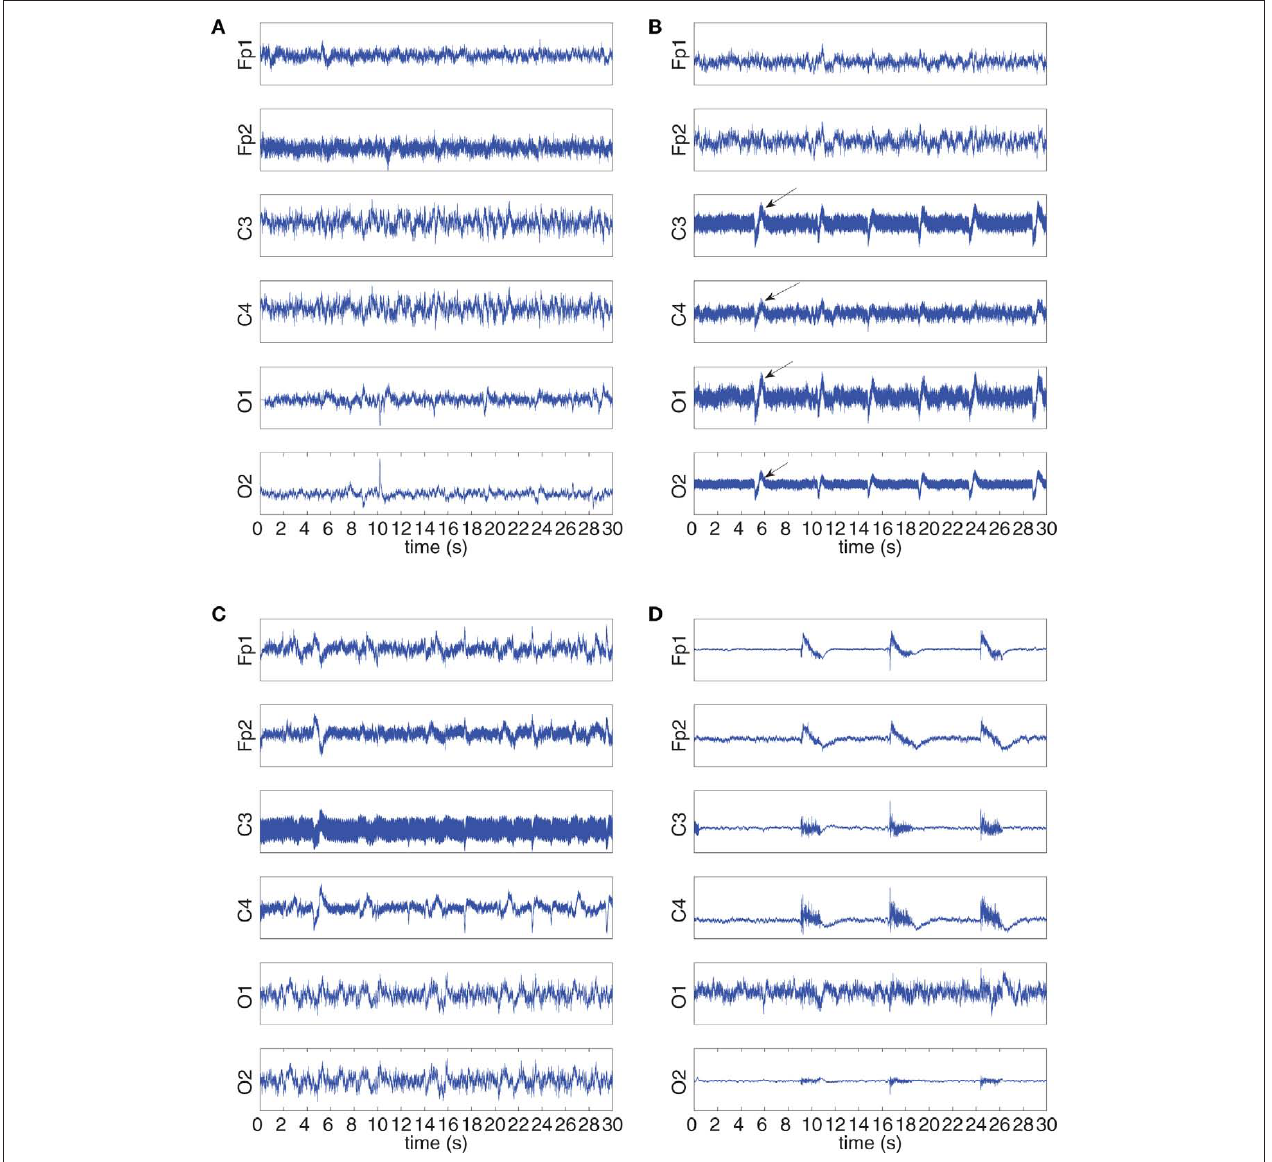
FiGurE 13 | EEG after extracting artifacts from the “ E yEblink ,” “ E yE r oll ,” and “ E yE b row ” set. (A) E yEblink : Kurtosis-based method. (B) E yEblink : Predictor-based method in (Javidi et al., 2010). (C) E yE r oll : Kurtosis-based method. (D) E yE b row : Kurtosis-based method.